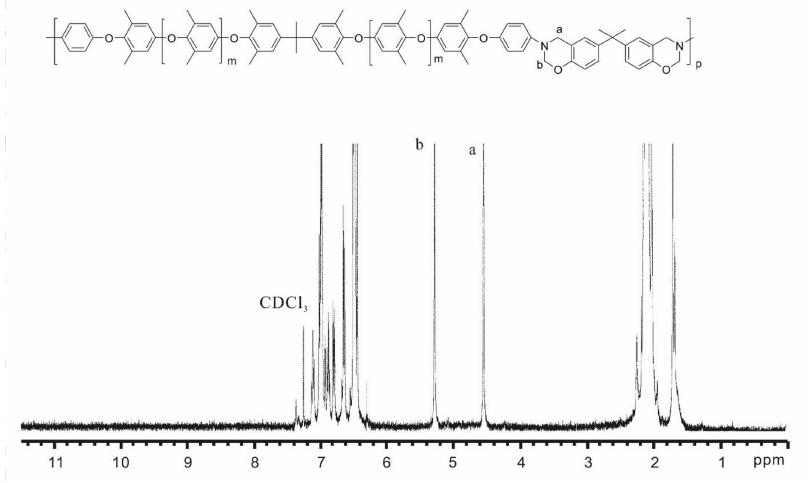
Figure 5. 1 H-NMR spectrum of BPA-APPO in CDCl 3 .